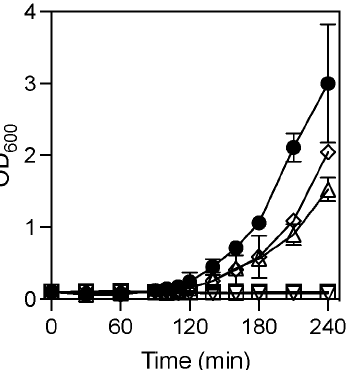
Figure 8. The outgrowth of spores of C. perfringens wild-type, mutant, and complemented strains. Heat-activated spores of C. perfringens strain SM101 (wild-type) ( • ), ∆ ytxC mutant ( ∇ ), ∆ ytxC+ytxC ( ∆ ytxC mutant complemented with wild-type ytxC ) ( ♦ ), ∆ yyaC2 mutant ( (cid:3) ), and ∆ yyaC2+yyaC2 ( ∆ yyaC2 mutant complemented with wild-type yyaC ) ( ∆ ) were inoculated in pre-warmed TGY broth and the OD 600 was measured as described in Material and Methods. The data represents the means of three individual replicates and error bars represent standard deviations.